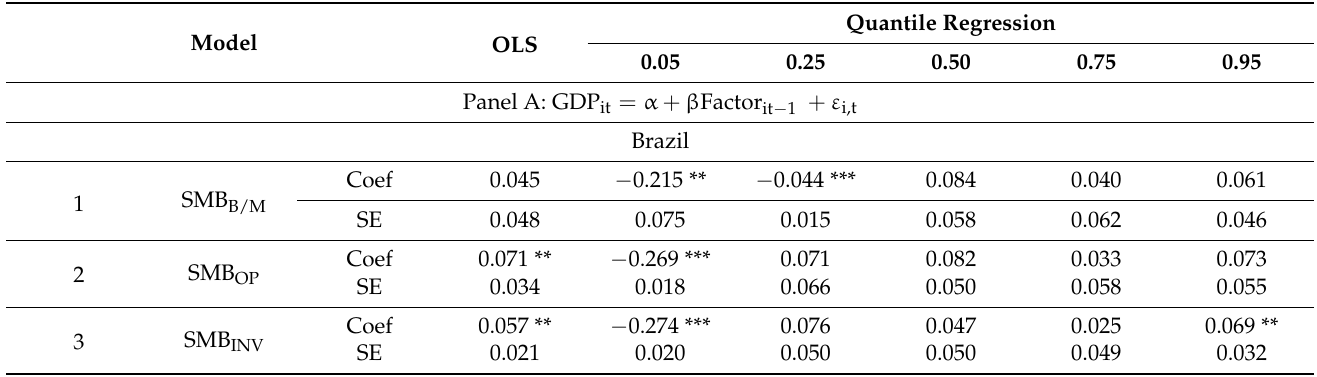
Table A1. Simple and Multiple Regression Estimates with Two Explanatory Variables Risk Factors MKT, SMB B/M , SMB OP and SMB INV